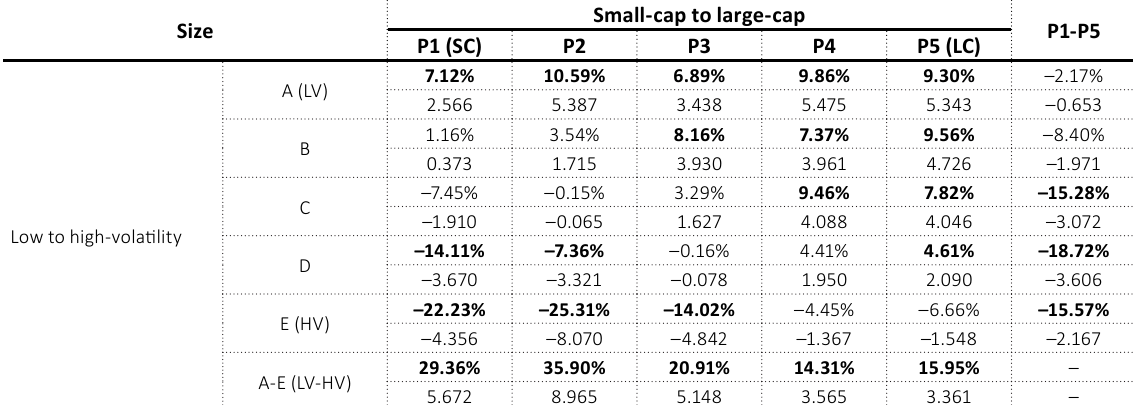
Table 9. Fo ur-factor alpha of quintile portfolios independently sorted on size and volatility